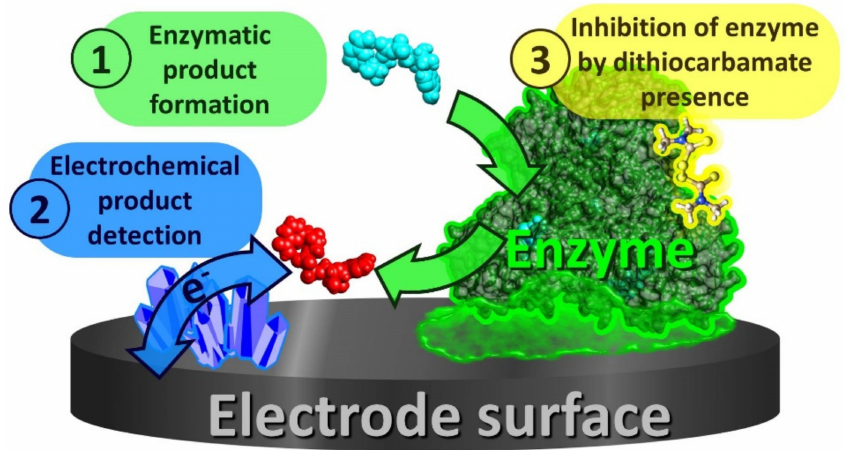
Figure 5. Generalized schematic of the operating principles of DTF-monitoring electrochemical biosensors. 1: During operation, enzymes immobilized at, or near an electrode, are supplied with their required cofactors and substrates which produce a constant rate of enzymatic product. 2: The electrochemical detection of the formed enzymatic products generates the biosensor’s signal. 3: The presence of DTF pesticides inhibits the enzyme activity, lowering the electrochemical signal to an extent proportional to DTF